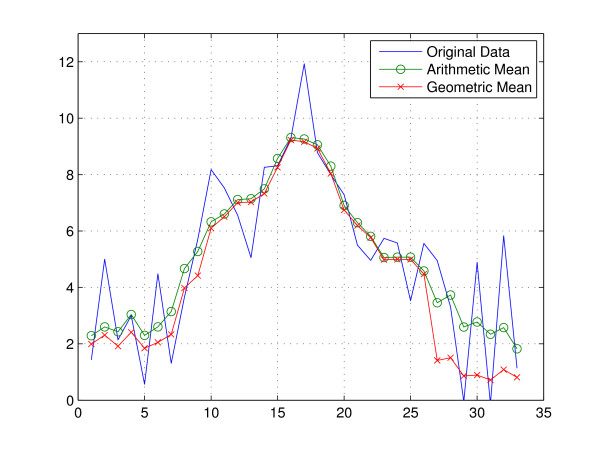
Arithmetic mean [n] vs. Geometric mean [n]. Although similar results might be obtained by the arithmetic mean filtering, for the region where the peak assumption is violated (e.g., the data is away from the peak), they becomes distinct.